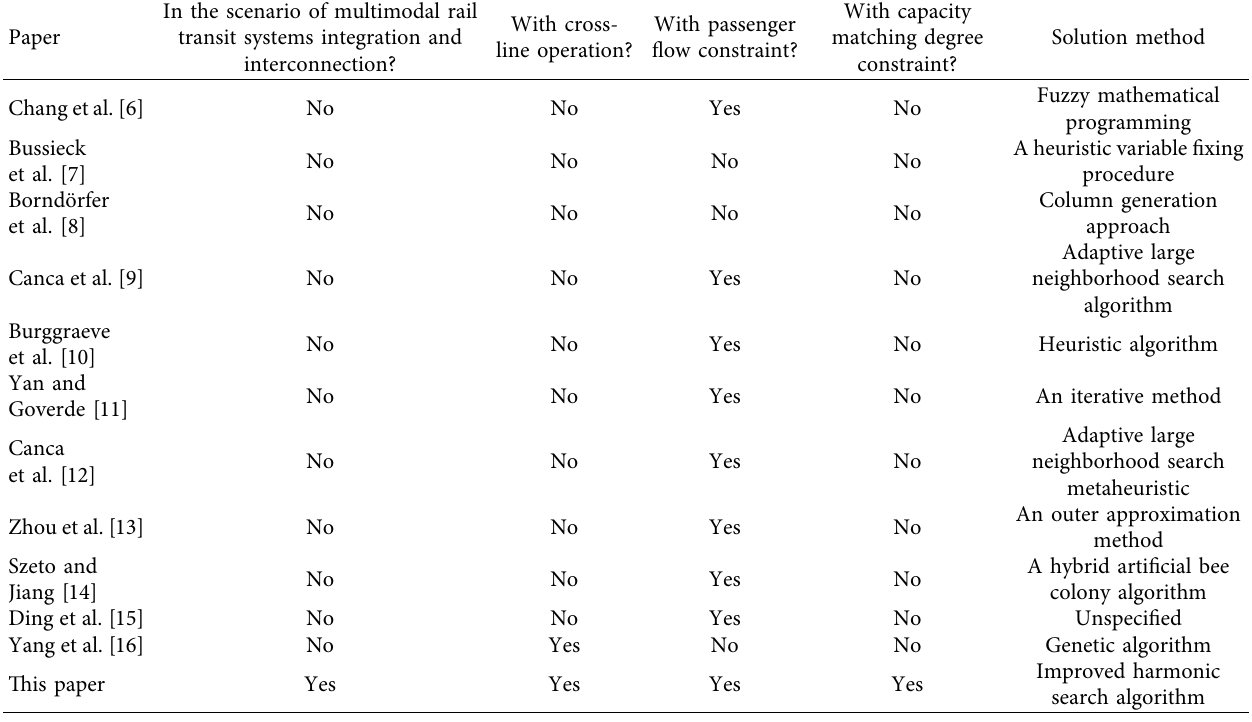
Table 1: The comparison between this paper and previous works.